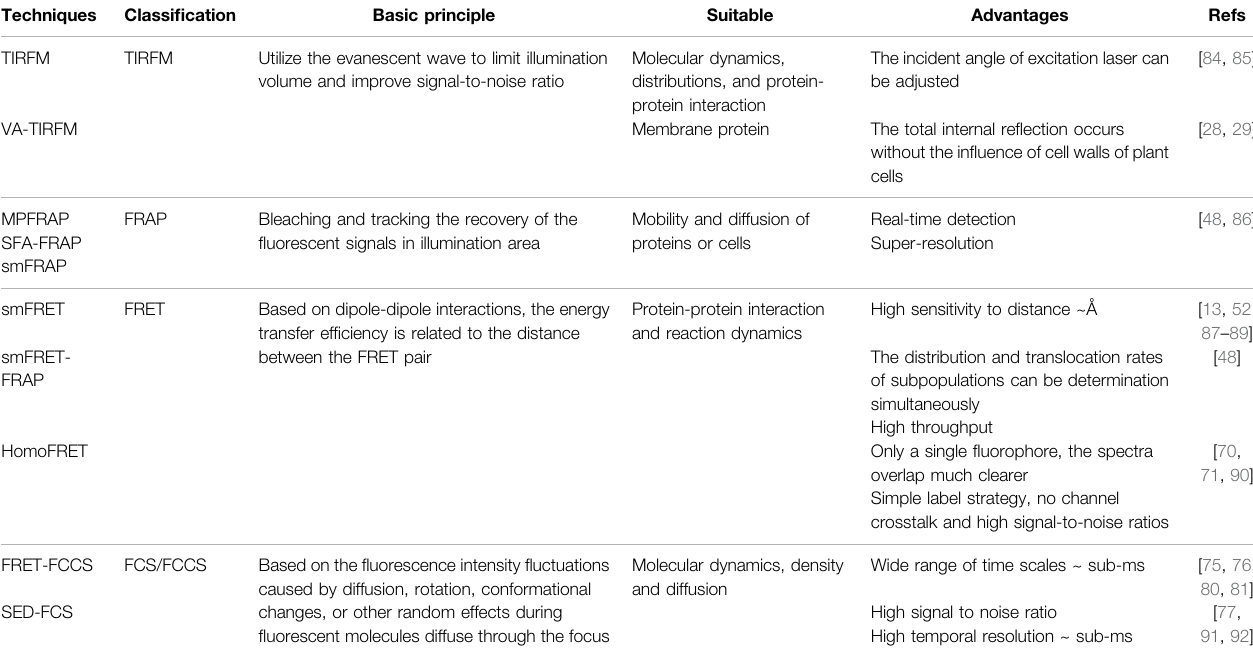
TABLE 1 | Classi fi cation and advantages of different fl uorescent single-molecule detection